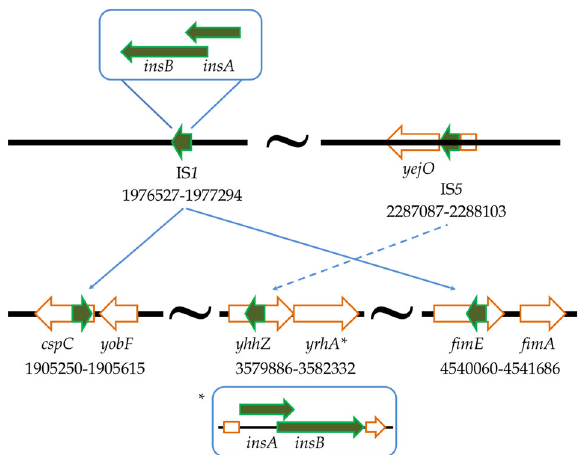
Fig. 2 An insertion of the transposon IS1 to the left of position 1,905,401 in the forward orientation (+) is predicted (coordinate as 1,905,409 on the left side and then goes into the IS1 element, which is inverted, and then comes out at 1,905,401 and continues to higher coordinates. All of this occurs within the “ cspC ” gene, thereby likely making it dysfunctional. Likewise, transposon insertions have been predicted for positions 3,580,708 (four base pairs) and 4,540,601 (nine base pairs), disrupting the genes yhhZ (conserved protein) and fi mE (tyrosine recombinase/inversion of on/off reg- ulator of fi mA ), respectively. The JC (New junction) evidence